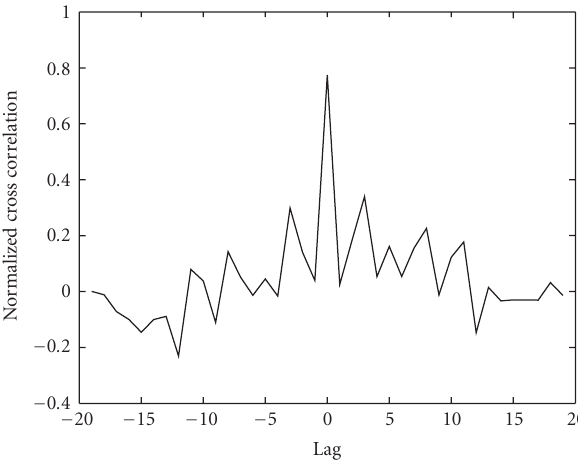
Figure 3: Cross correlation between Proposed and